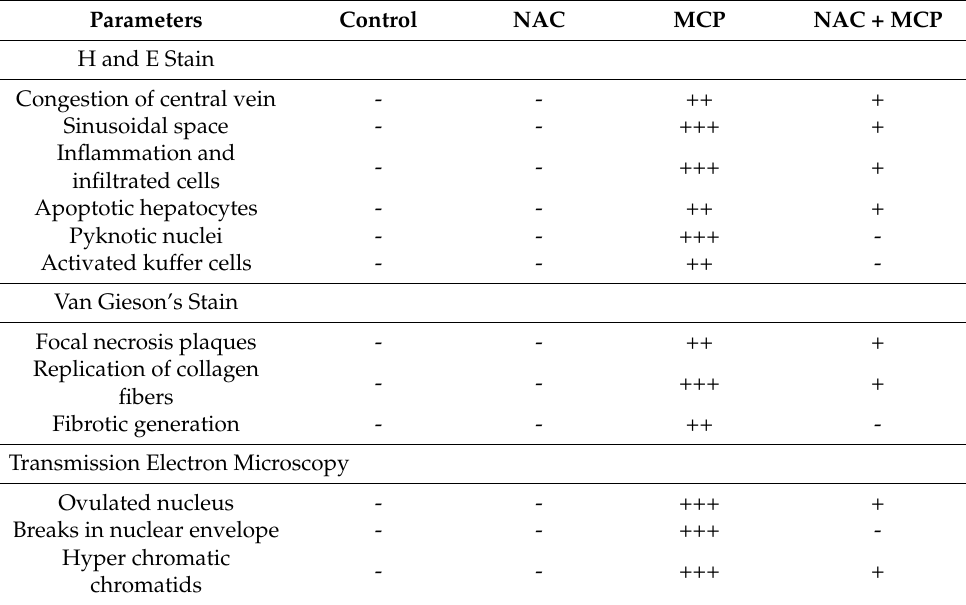
Table 5. Description of histological alterations and structural assessment in different groups of the study (N =